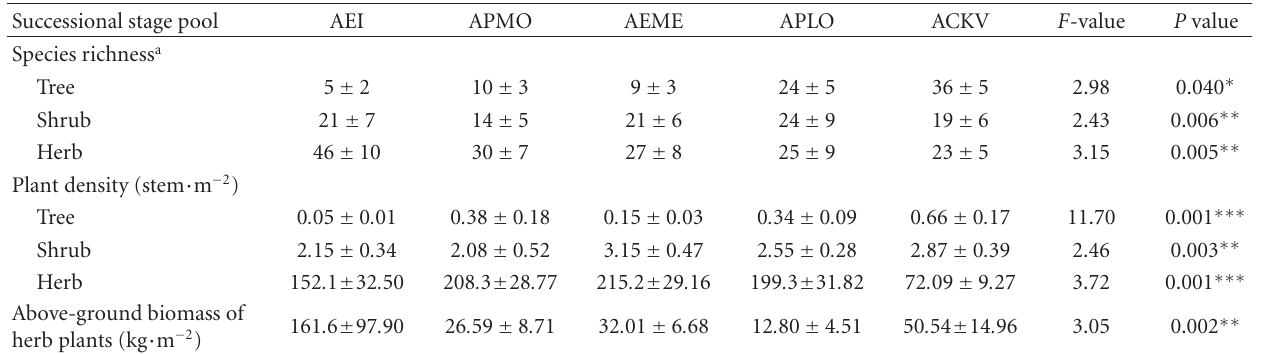
Table 3: Parameters reflecting the measures of filter processes in successional-stage species pools.